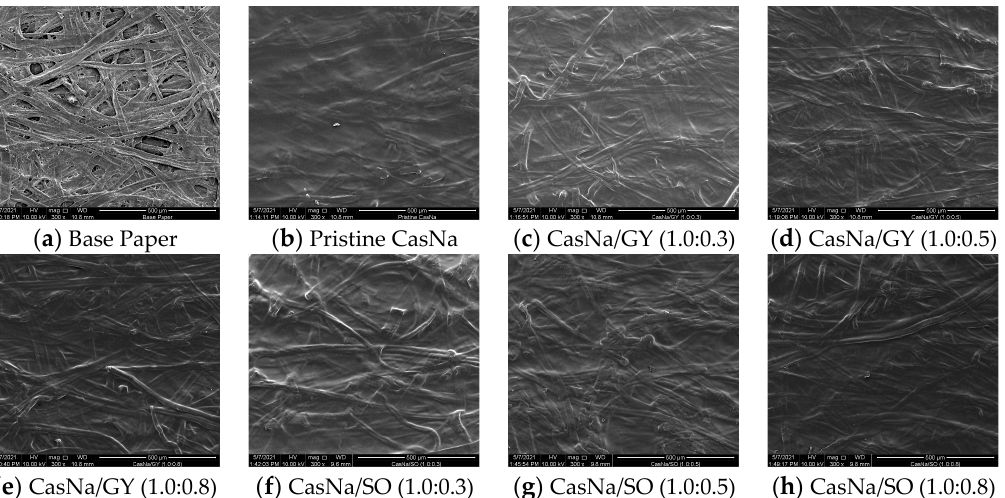
Figure 1. SEM images of ( a ) base paper, ( b ) pristine CasNa-coated paper, ( c – e ) CasNa/GY–coated papers and ( f – h ) CasNa/SO–coated papers ( × 300